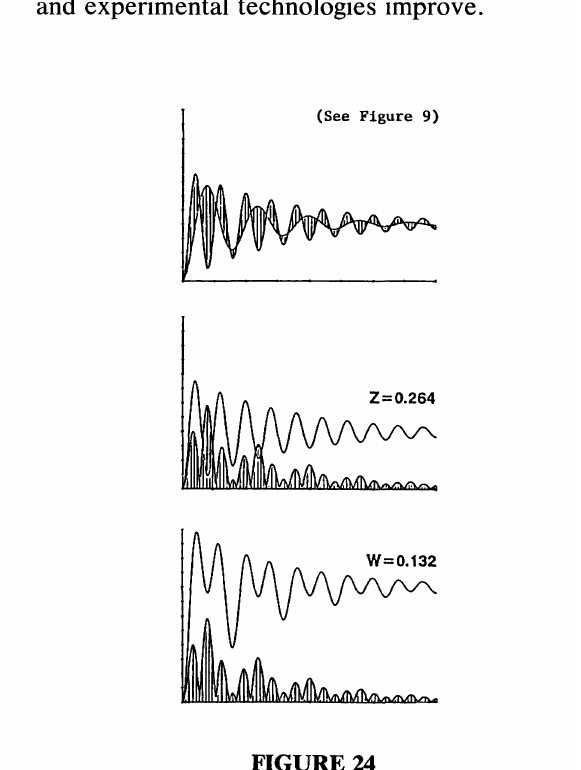
less than 0.1, good for W values between 0.1 and 0.3, etc., and similar words for Z. These words are clearly subjective, and the range of values for each word changes as both the computational and experimental technologies